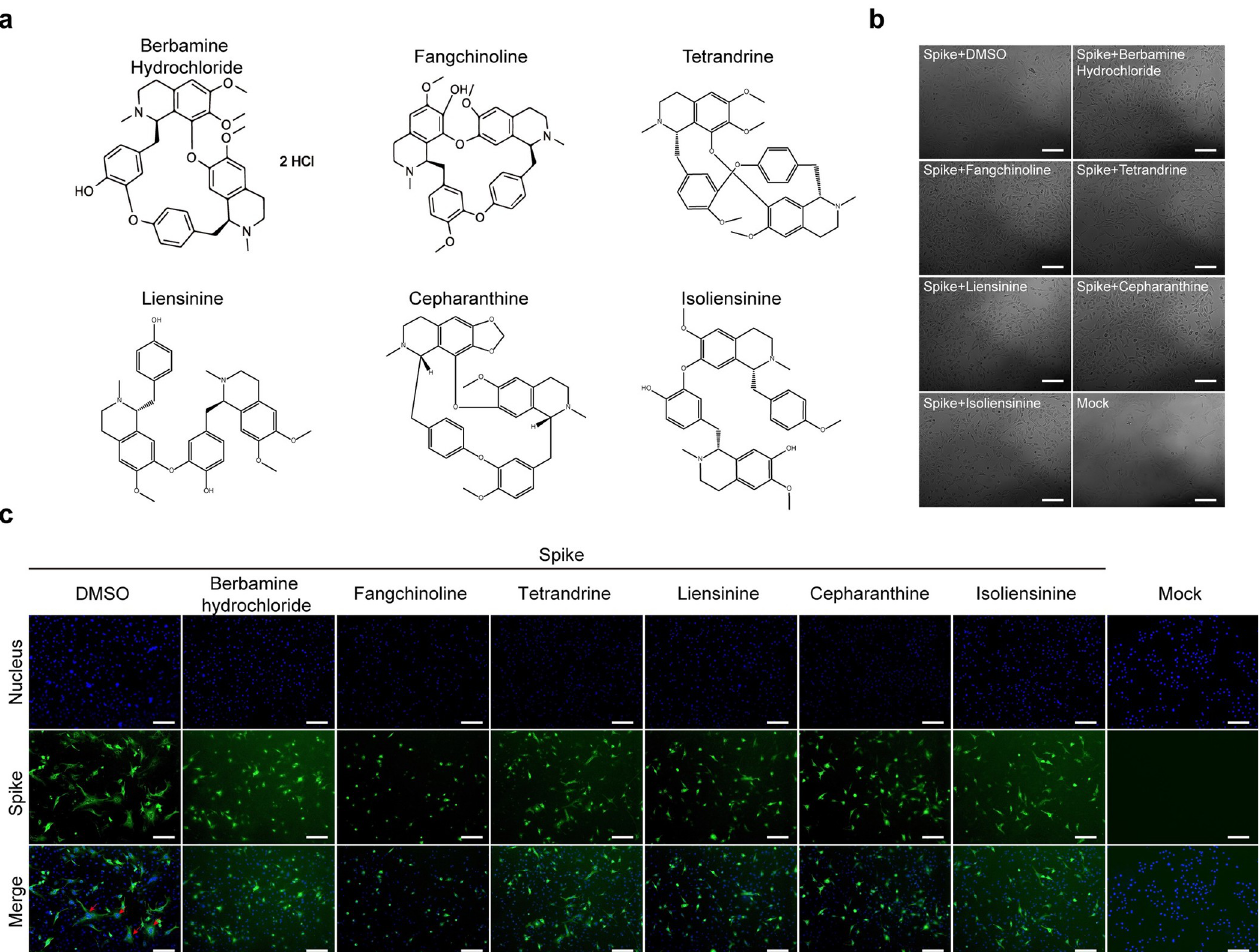
Fig 4. Microscopic observation and immunofluorescence analysis the inhibitory activity of bis-benzylisoquinoline alkaloids against SARS-CoV-2 S- mediated cell–cell fusion. (a) Structure of bis-benzylisoquinoline alkaloids. Vero-E6 cells co-culture with BHK that transfected with the SARS-CoV-2 S expression construct and treated with 10 μ M berbamine hydrochloride, liensinine, isoliensinine, tetrandrine, fangchinoline, cepharanthine or DMSO. Cells were harvested at 12 h after treatment. The syncytial phenotype is indicated by the multinucleated giant cells as indicated by the red arrows. (b) Microscopic observation and (c) immunofluorescence images of cells staining with DAPI (blue) or anti-S Ab (green). Scale bar, 100 μ m. Experiments were performed at least twice with two technical replicas per experiment.